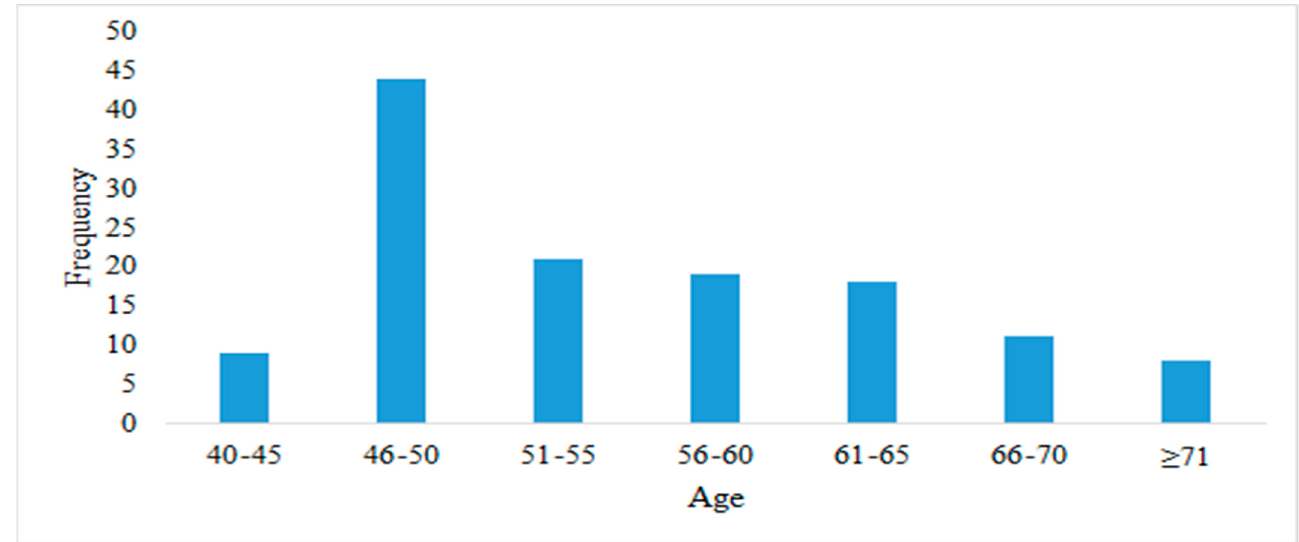
Figure 6. Number of patients by age. Susceptibility to prostate cancer is high at age 46–50; after this age range, the incidence is about 20% from age 51 to 65.